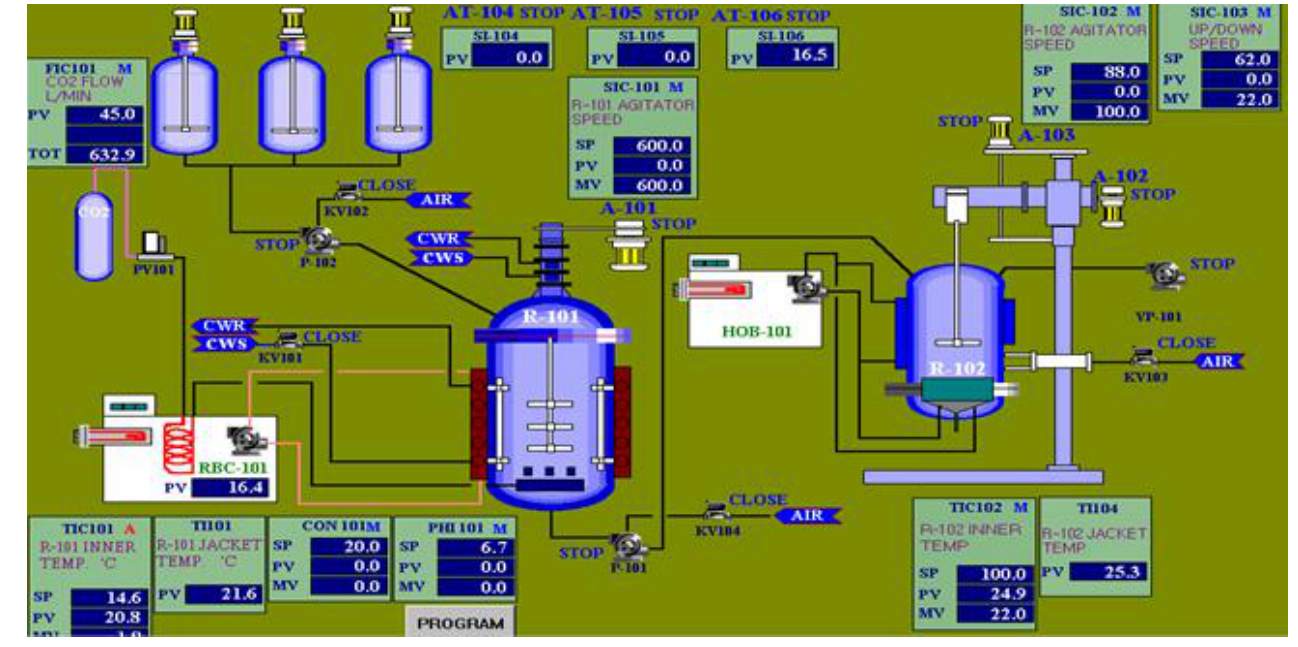
Figure 17. A pilot plant equipped with precipitated calcium carbonate (PCC) process system in Korea Institute of Geoscience and Mineral Resources (KIGAM), South